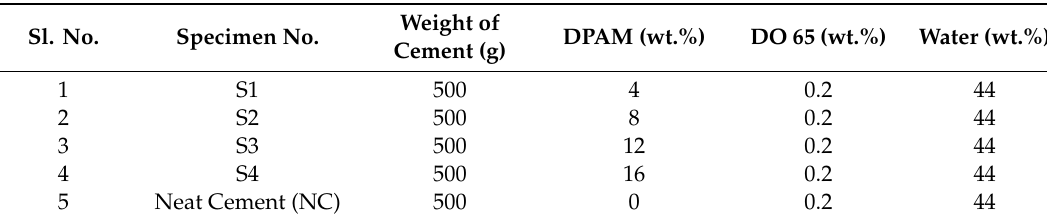
Table 2. Mixing proportion of the cement paste.